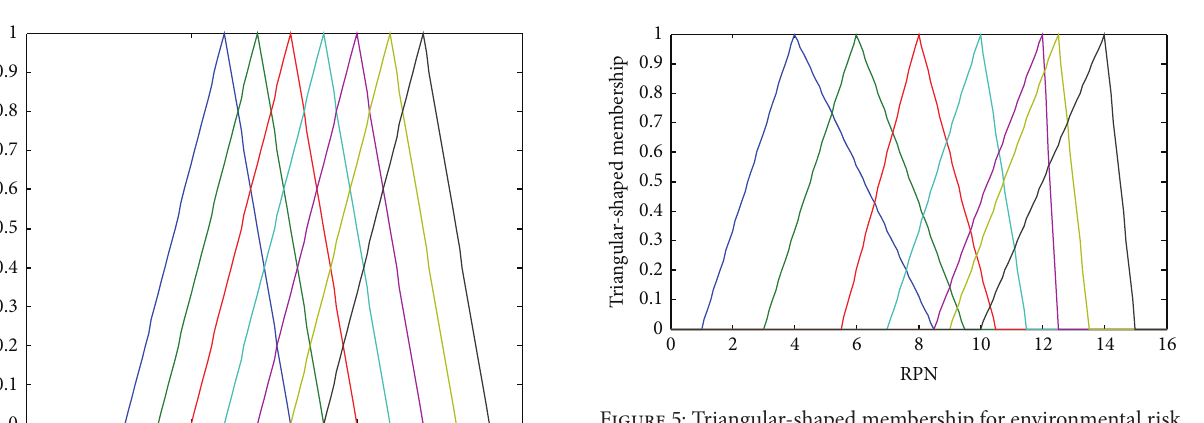
population rank : the lower-rank populations are se-